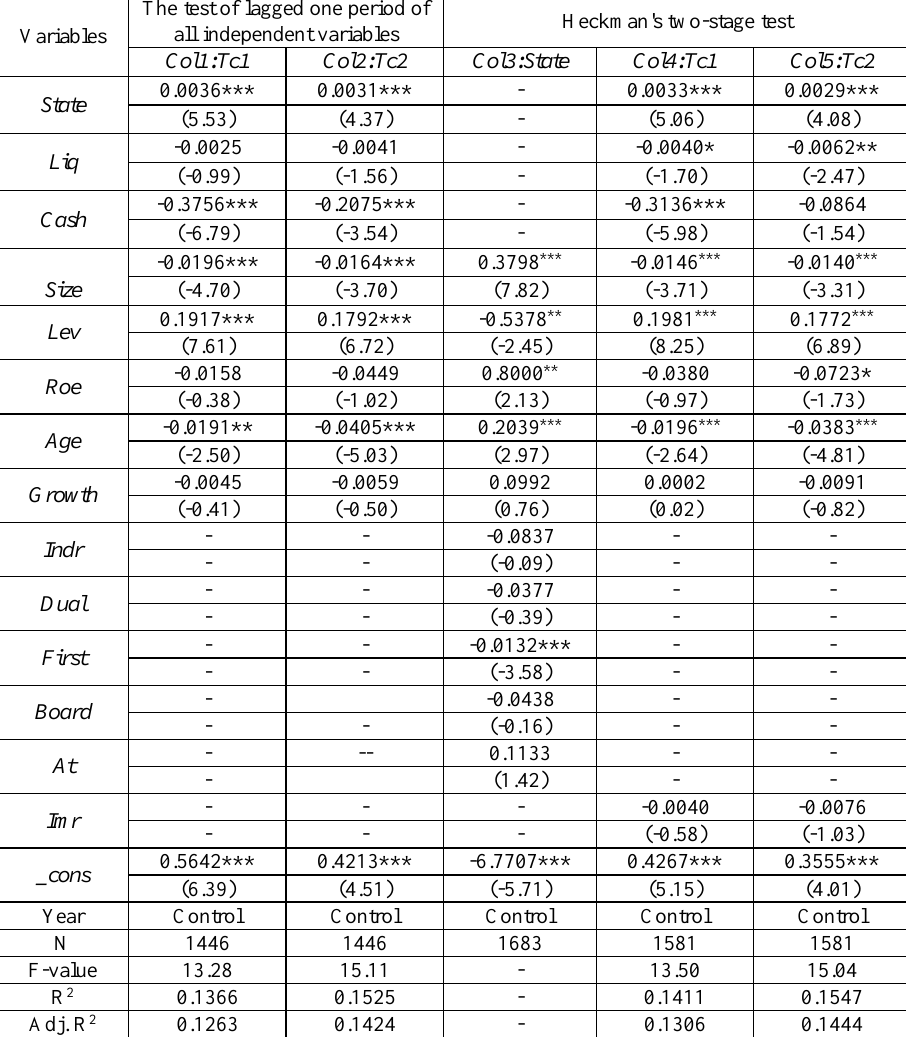
Table 2. The results of robustness tests a